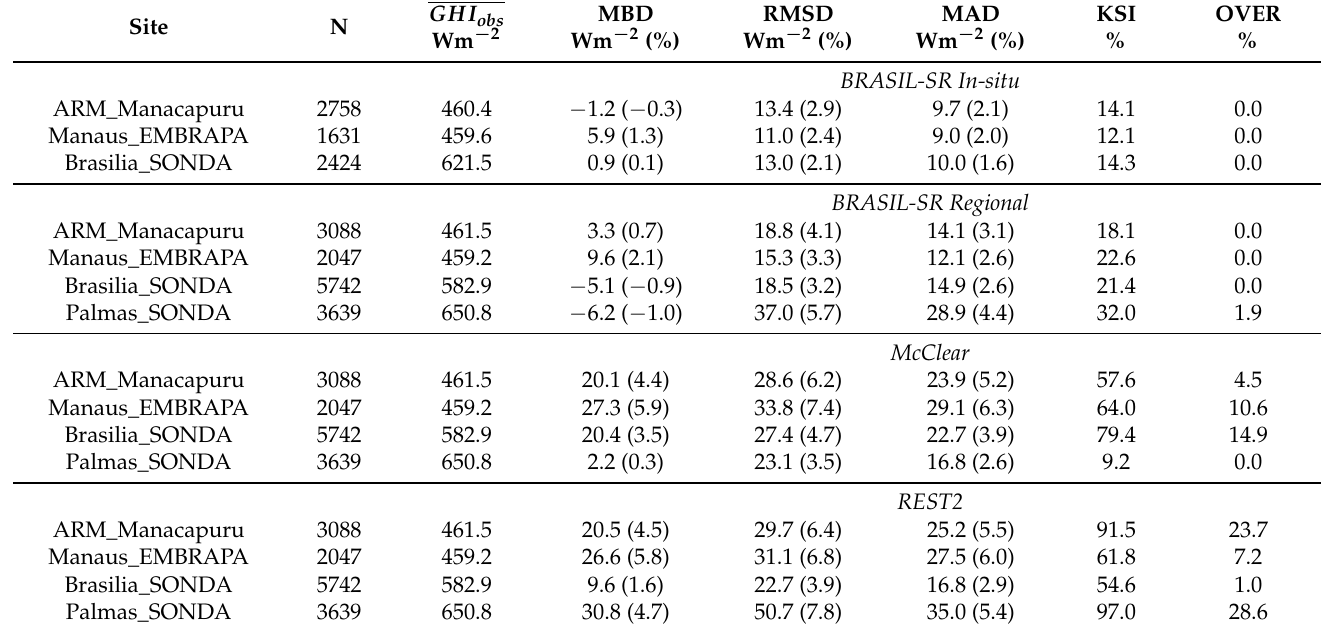
Figure 5. Scatter plot comparing observational GHI data and BRASIL-SR GHI outputs running the regional (grey dots) and in-situ experiments (red dots) for the four ground measurement sites. Table 3. Benchmark comparisons between clear-sky GHI observed and modeled using BRASIL-SR ( in-situ and regional experiments ), McClear and